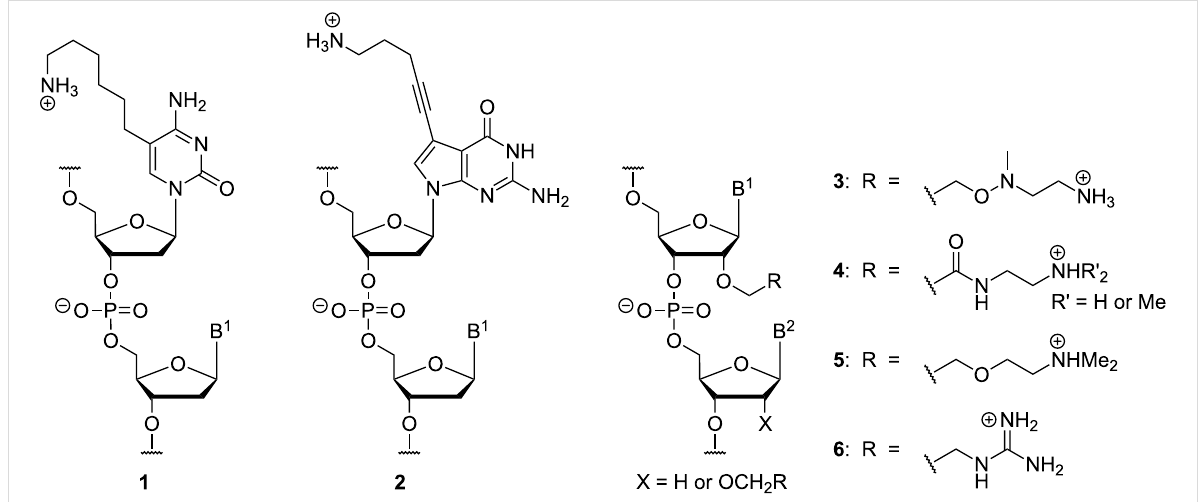
Figure 2: Selected examples 1 – 6 of nucleic acid modifications based on additionally attached positively charged moieties, but retaining an intact phosphate diester backbone (B 1 , B 2 = nucleobases) [30-37].